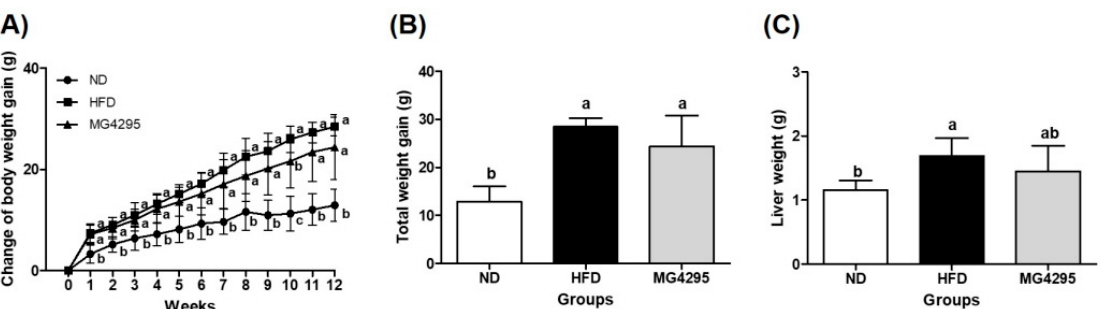
Figure 1. Effect of the L. fermentum MG4295 on ( A ) change in body weight gain, ( B ) total weight gain, and ( C ) liver weight gain in HFD-induced mice for 12 weeks. The results are presented as mean ± SD ( n = 8). Different letters indicate a significant difference at p < 0.05.